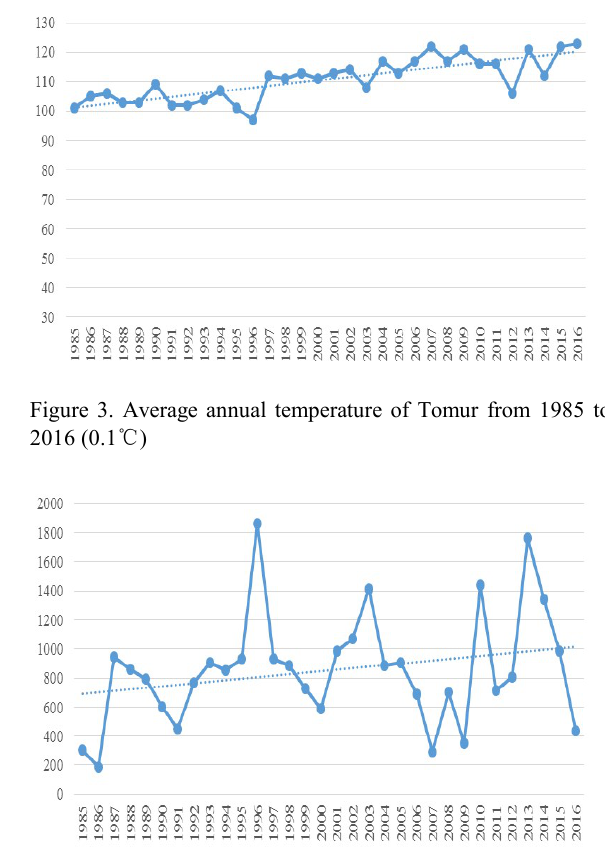
Figure 4. Average annual precipitation of Tomur from 1985 to 2016